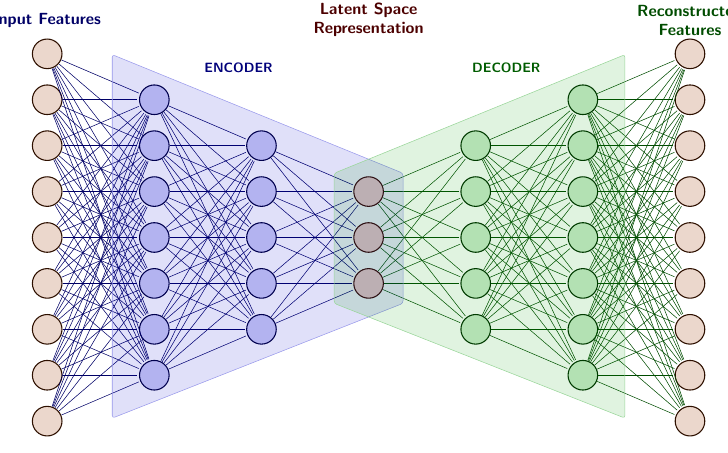
Figure 1. Architecture of a generic